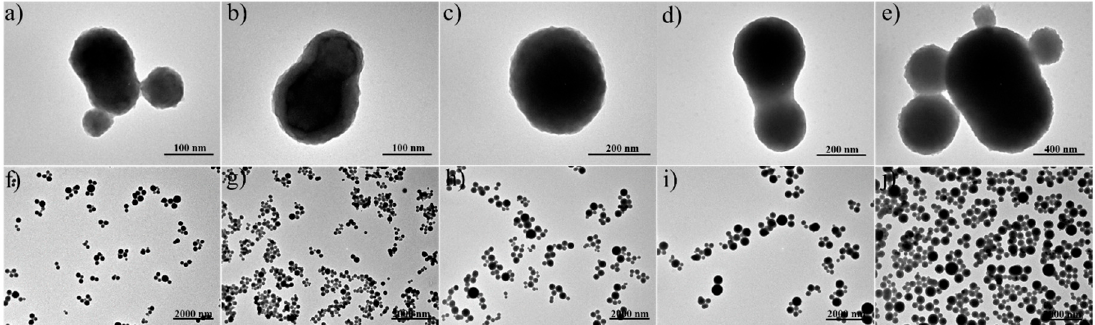
Figure 4. TEM micrographs at high magnification show isolated nanoparticles with details in the morphology and nanostructure. TEM micrographs at low magnification show size and shape distribution of BSA-capsaicin nanoparticles at different capsaicin concentrations. All experiments in TEM were carried out at 80 kV high voltage (EHT) at 710,000× to 140,000× (high magnification), and